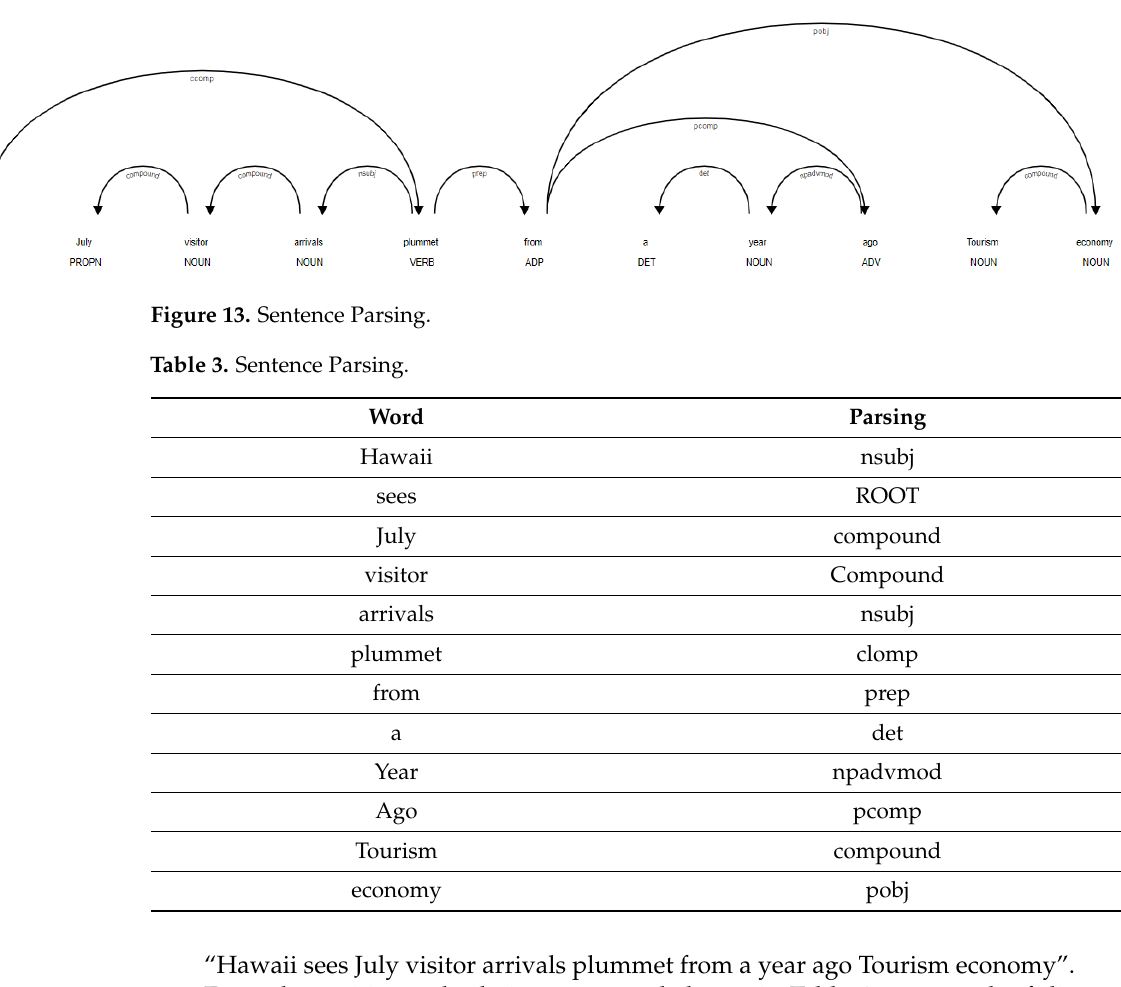
Table 4. Frequency of Relations Extracted.